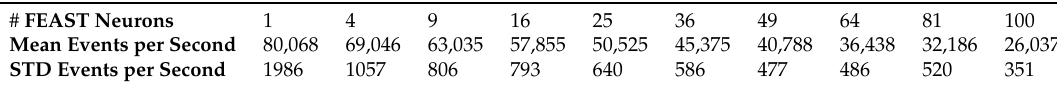
Table 3. Time performance